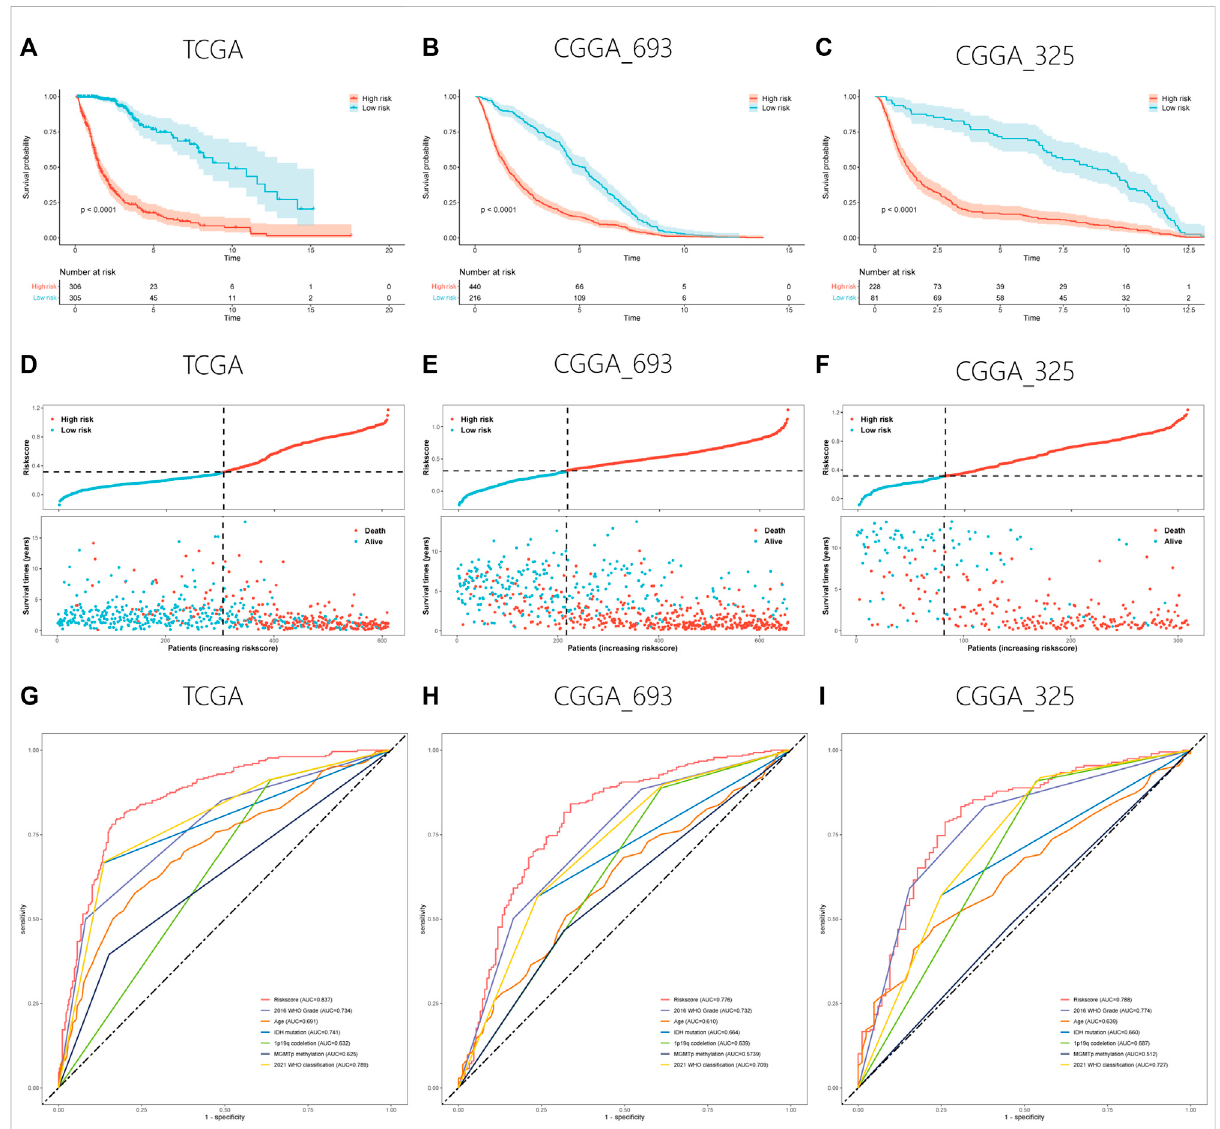
FIGURE 3 Validation of the PRL classi fi er. (A – C) The fi ndings of KM curves for the three different cohorts in the TCGA, CGGA_693, and CGGA_325. (D – F) Representation of the TCGA, CGGA_693, and CGGA_325 cohorts ’ risk score and survival status distribution plots. (E – G) Multiple ROC curves depicting the risk score as well as clinical variables for the TCGA, CGGA_693, and CGGA_325